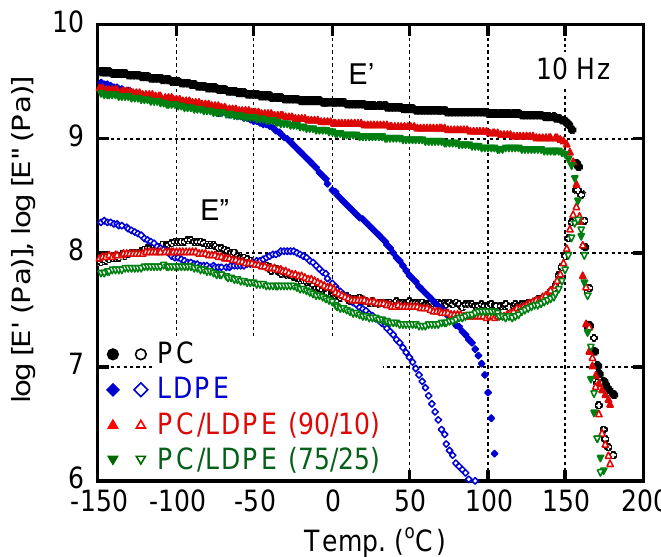
Figure 4. Temperature dependence of tensile storage modulus E’ (closed symbols) and loss modulus E” (open symbols) at 10 Hz for PC (circles), LDPE (diamonds), PC/LDPE (90/10) (triangles), and PC/LDPE (75/25) (inverted triangles).